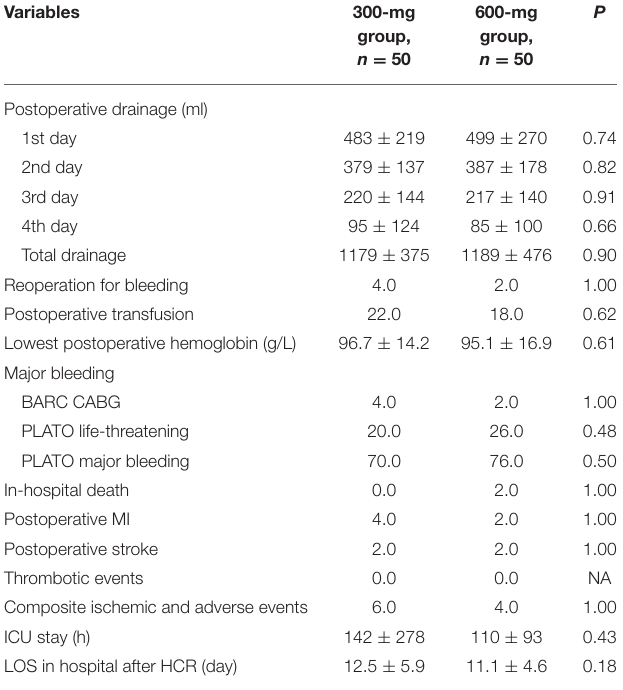
TABLE 3 | Postoperative outcomes of patients according to the study groups.